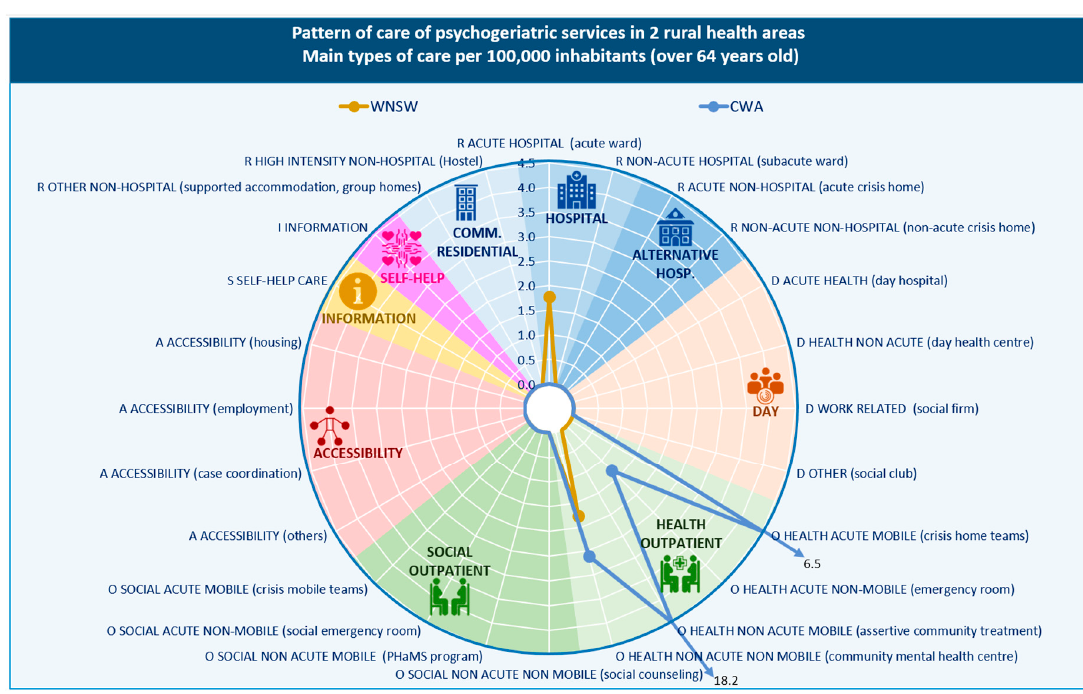
Figure 4. Pattern of care of mental health services in Western New South Wales and Central Western Australia rural areas: main types of care per 100,000 inhabitants aged 65 years and over. WNSW; western New South Wales, CWA; country Western Australia.